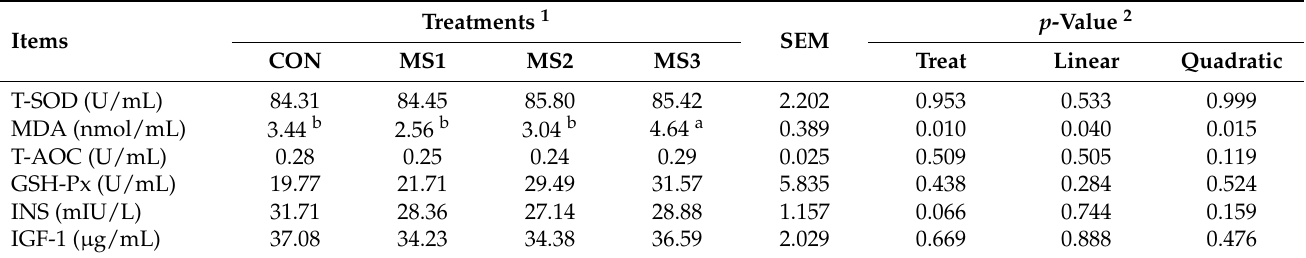
Table 5. Effect of MetaSmart supplementation in diets on serum antioxidant indexes and growth hormone of yaks.